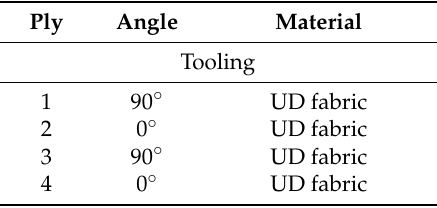
Table 1. Stacking sequence and fiber Bragg grating (FBG) placement valid for all